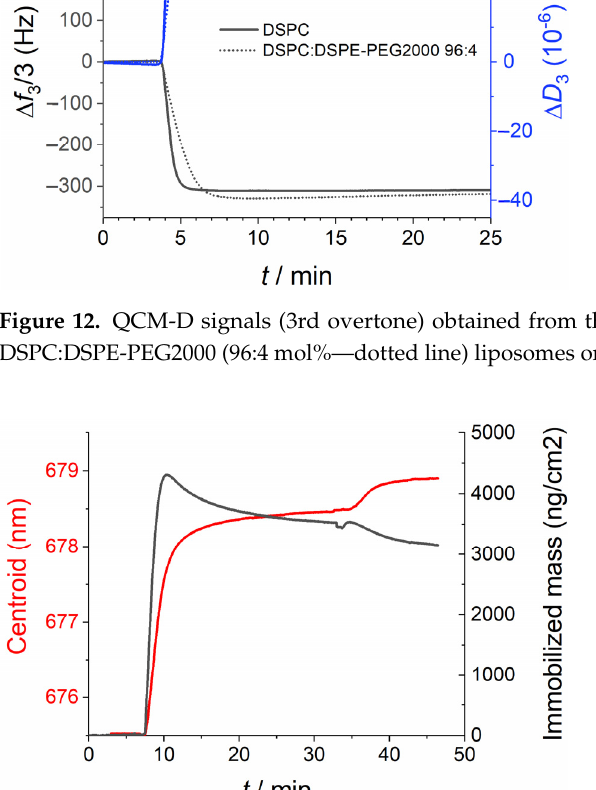
Figure 12. QCM-D signals (3rd overtone) obtained from the adhesion, of DSPC (solid line) and DSPC:DSPE-PEG2000 (96:4 mol%—dotted line) liposomes on a silica surface at 21 °C.